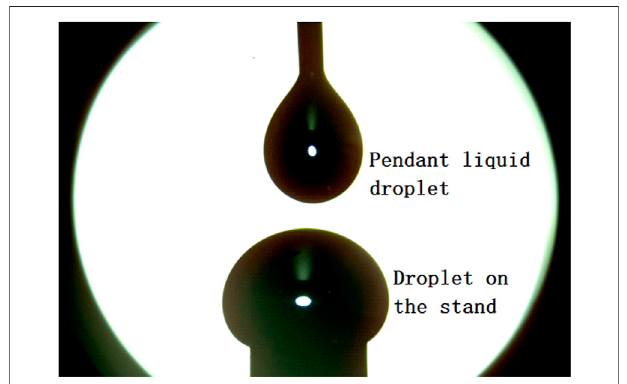
FIGURE 7 | Pendant liquid droplet and droplet on the stand by using municipal water.